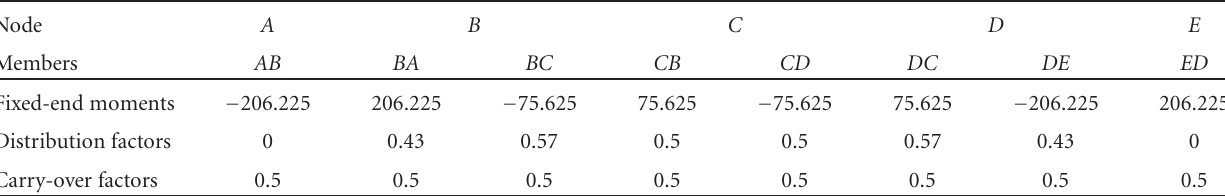
Table 3: Initial moments at the ends of the members and the distribution and carry-over factors for the third example.